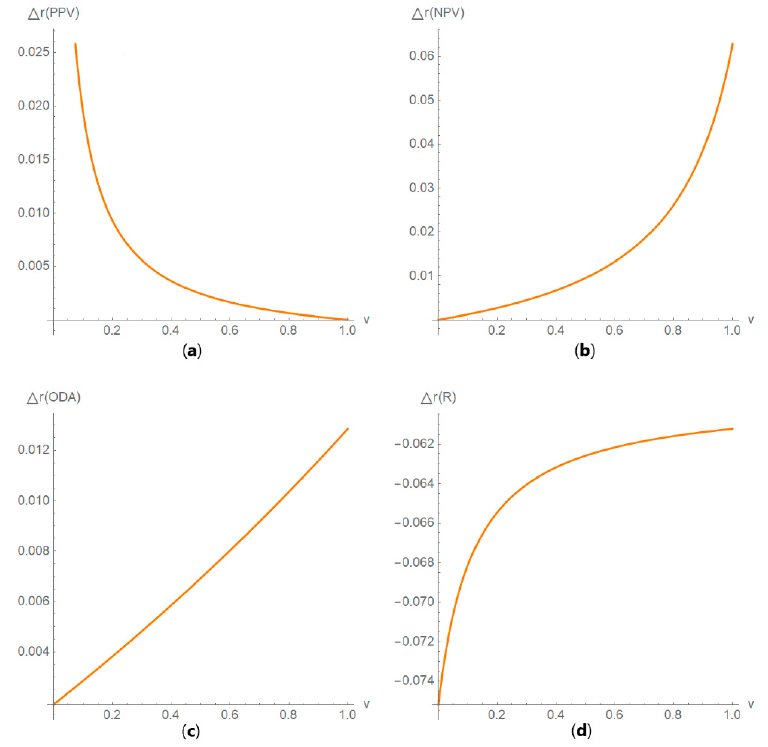
Figure 13 . DAM against uncertainty plots. Plots of ( a ) diagnostic odds ratio ( DOR ), ( b ) risk ( R ), ( c ) likelihood ratio for a positive result ( LR +) and ( d ) likelihood ratio for a negative result ( LR − ) against standard measurement uncertainty ( u ) curves, with the respective parameters in Table 4.